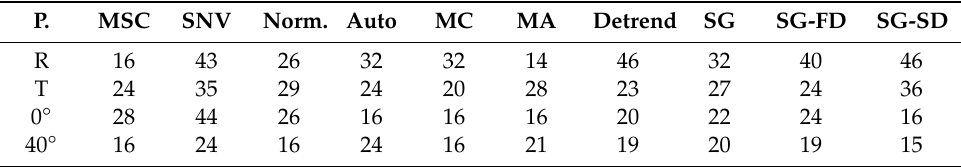
Table 6. Number of feature wavelengths extracted after CARS processing.